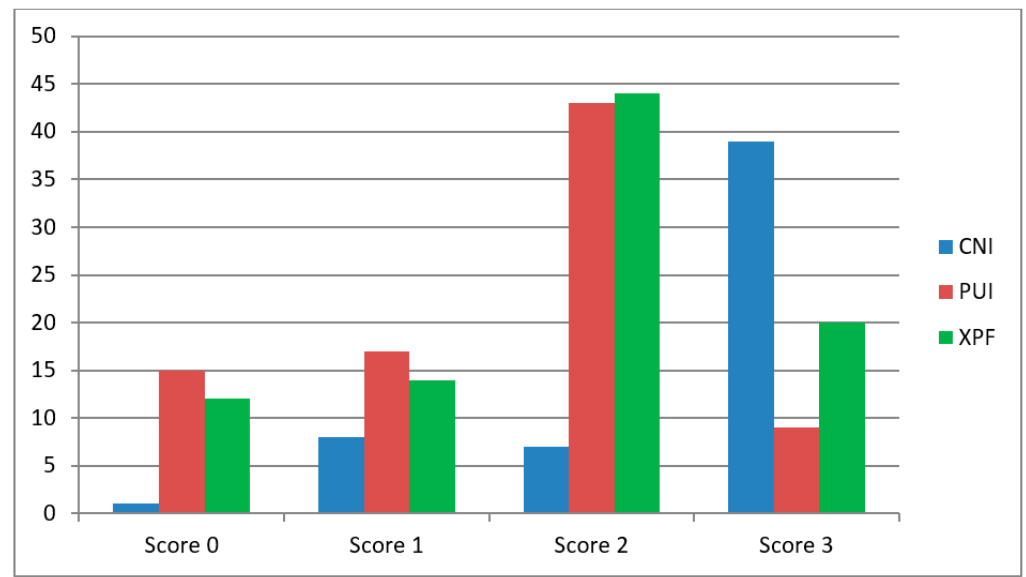
Figure 2. Distribution of scores for removing root canal debris in a sample of 222 teeth. Scoring system by Lee et al. and van der Sluis et al. → Score 0: Groove was empty; Score 1: Present in less than half of the grooves; Score 2: Present in more than half of the grooves; Score 3, The groove was completely covered [27,28].